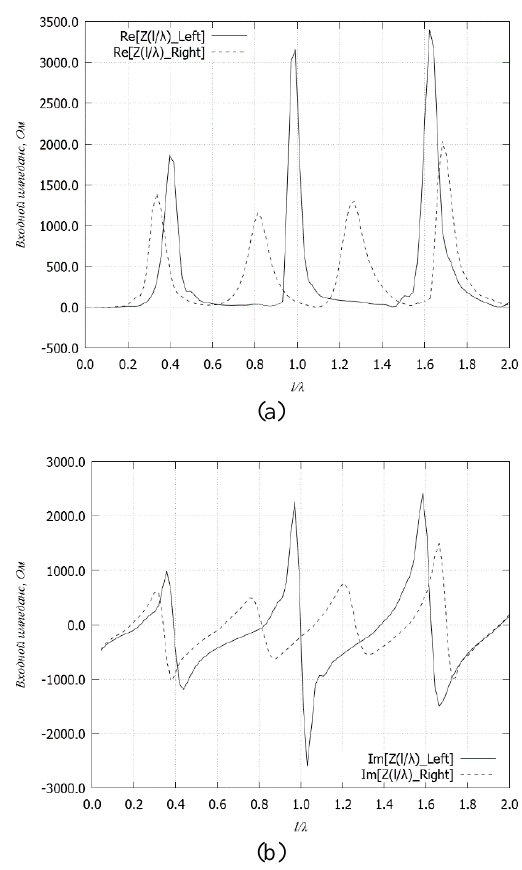
Fig. 3. Dependences of the real (a) and imaginary (b) parts of the input impedance of the first emitter from λl / upon excitation of one vibrator